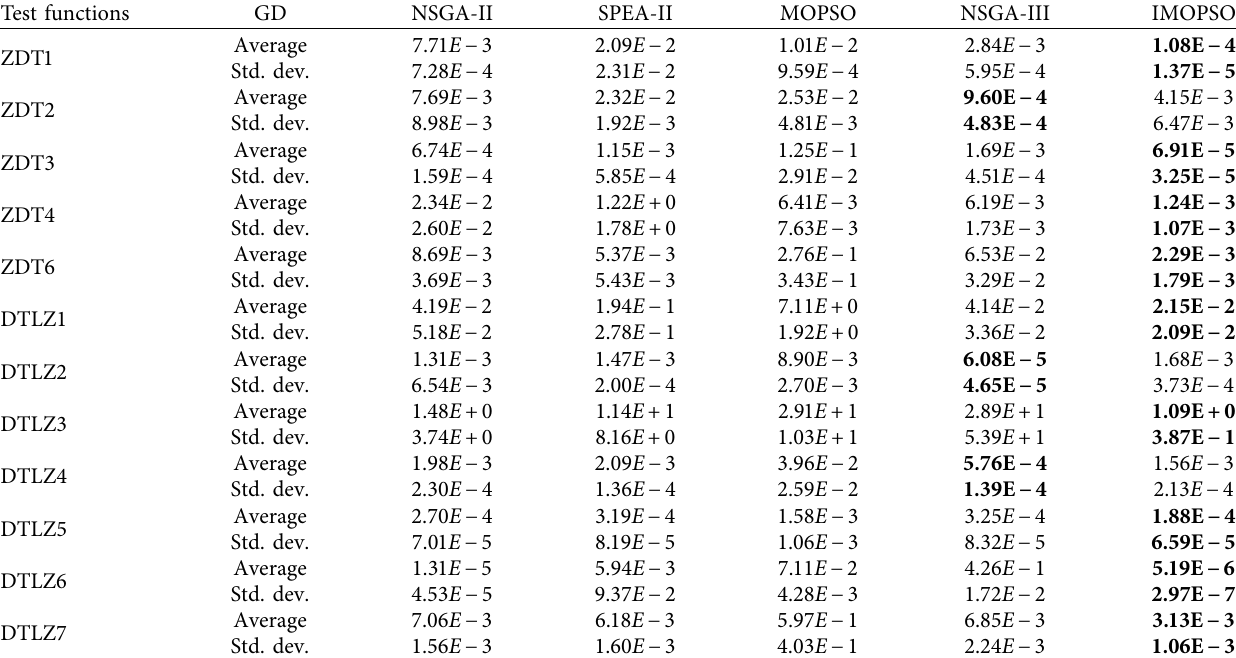
Table 5: Statistical results of GD obtained by different methods for different test